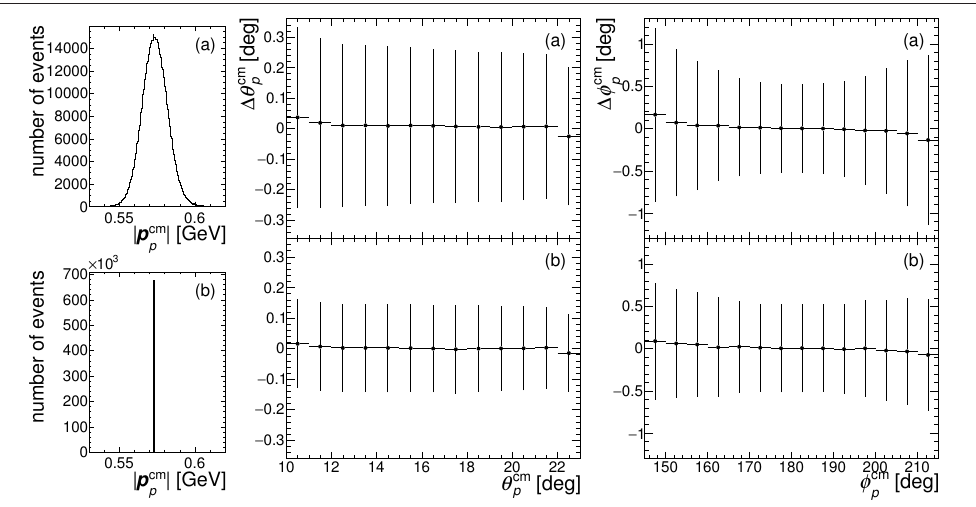
| , θ cm , φ cm ) in the center p p p